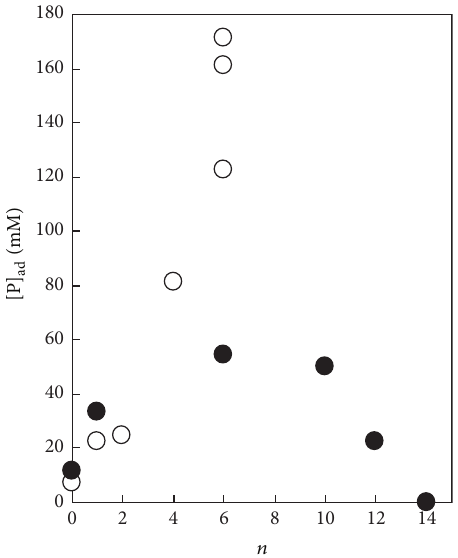
on n . 2 ( e ) and 3 ( ⃝ ). ad